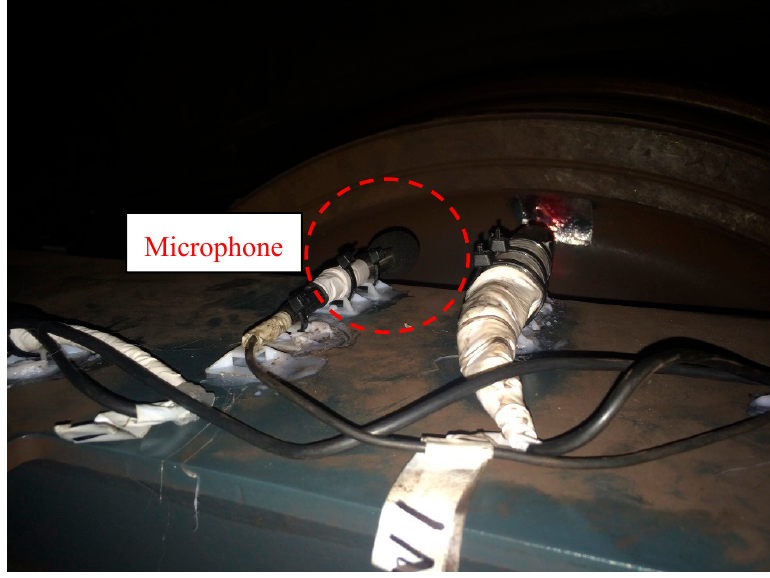
Figure 11. Microphone arrangement.